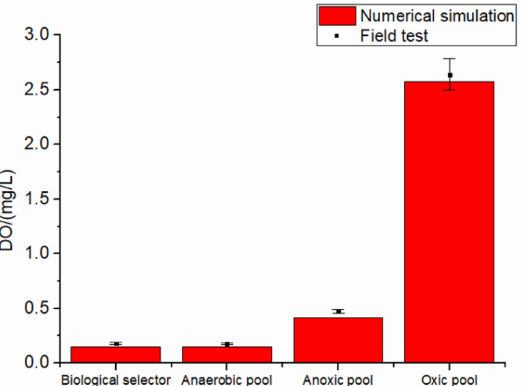
Figure 4. Comparison of the simulated average and measured DO concentrations in the four